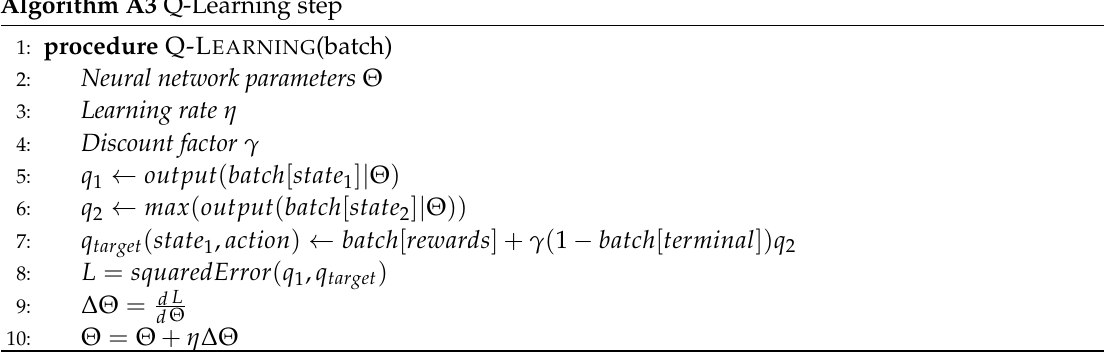
Algorithm A3 Q-Learning